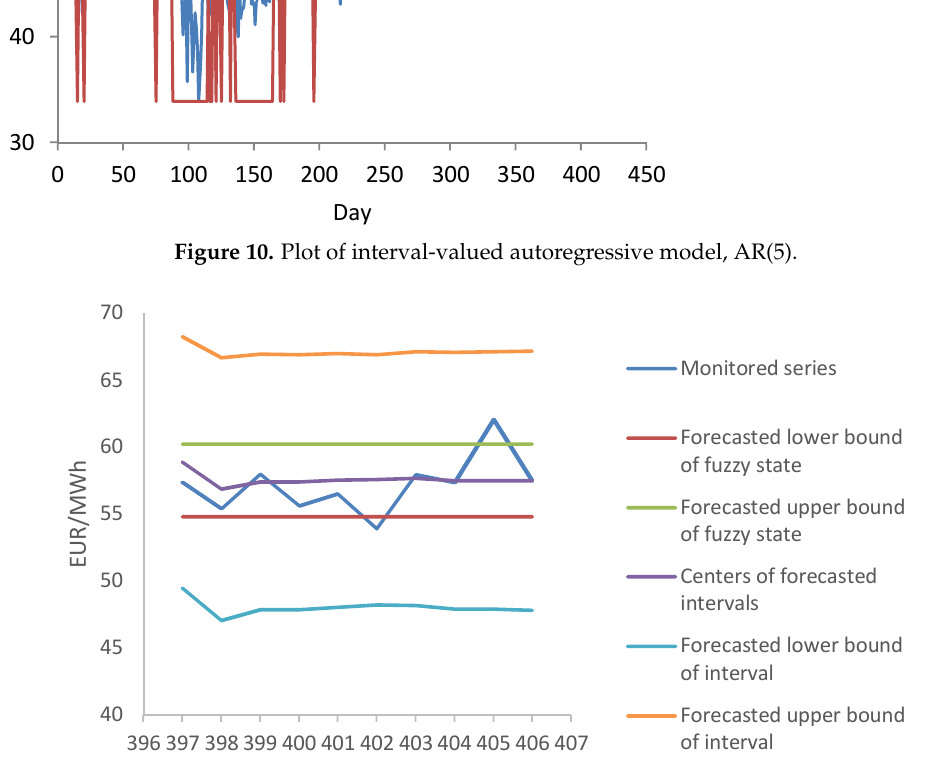
Figure 11. Monitored and forecasted values of electricity price for h = 10 days.